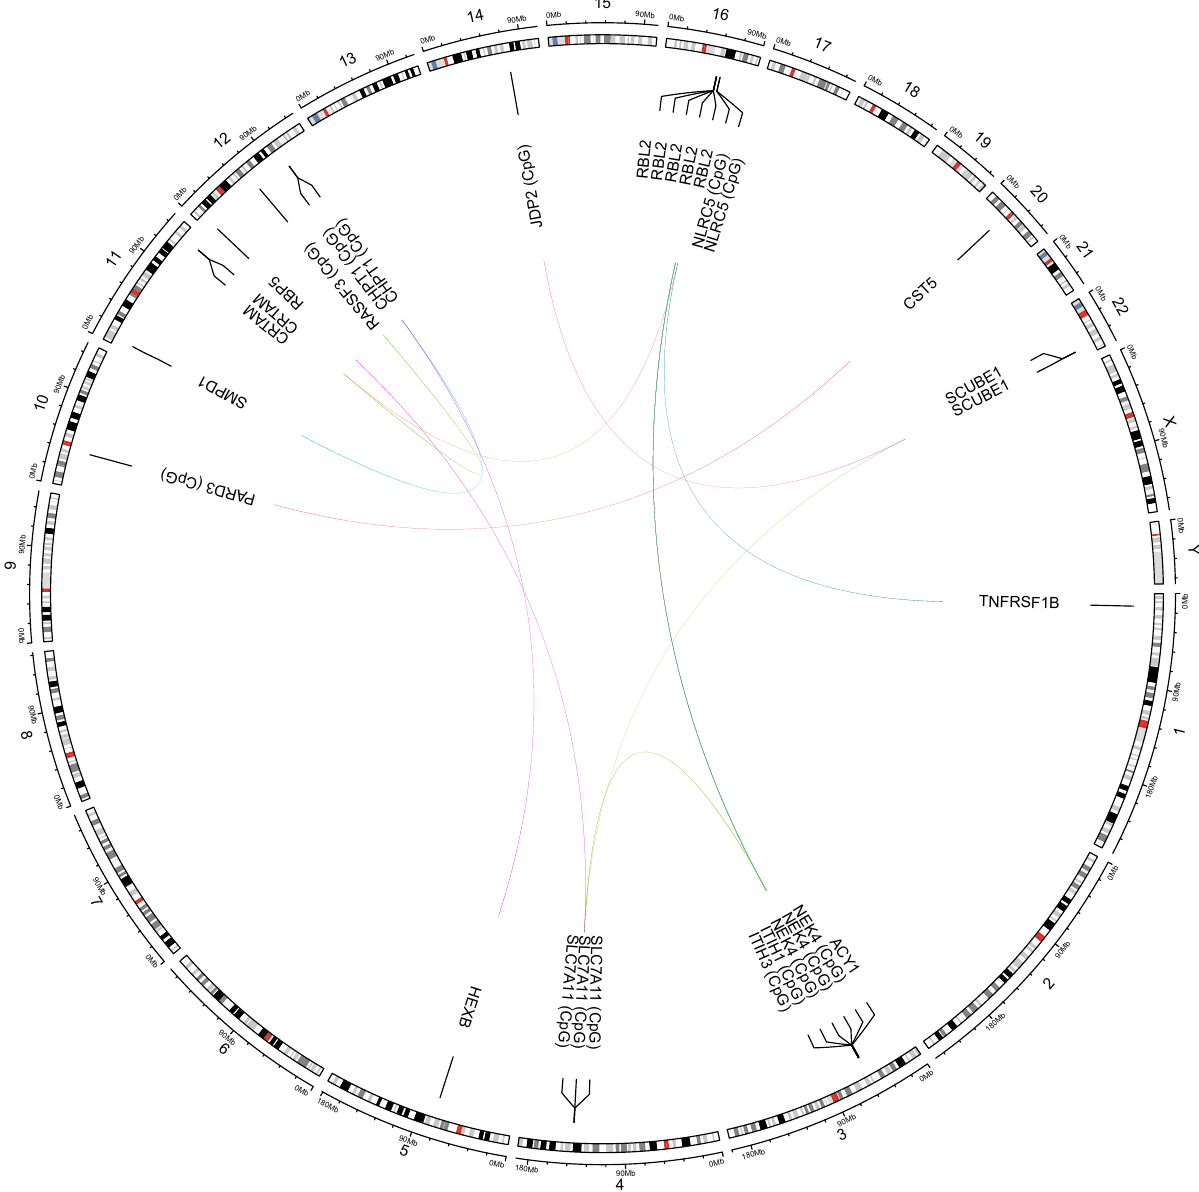
positions are given on the outermost circle. Details of the full set of 35 pQTMs for protein markers of brain health are provided in Supplementary Data 20 with P values. Results were generated through linear regression